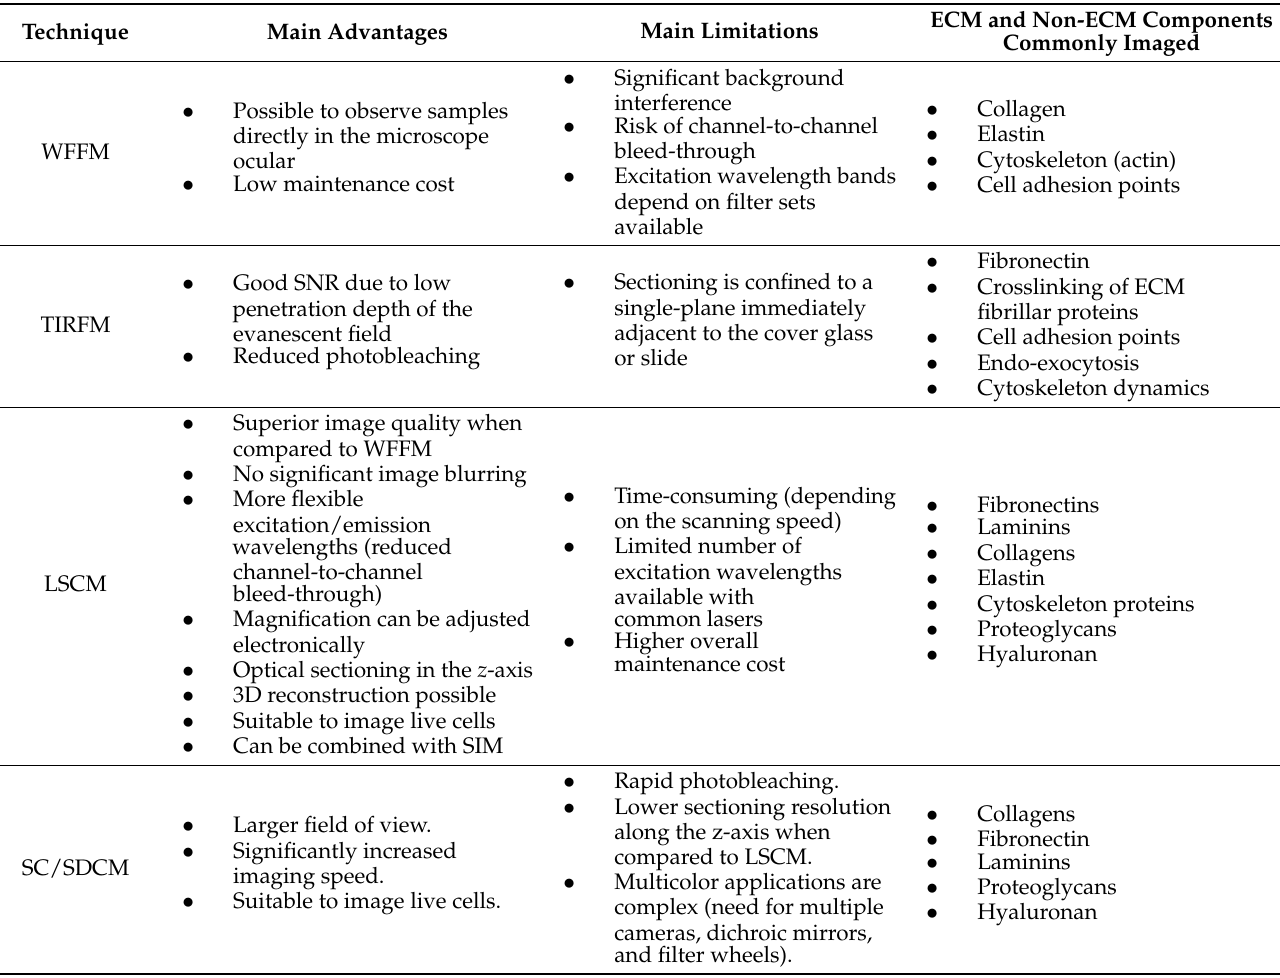
Table 1. The most commonly used linear fluorescence-based and diffraction-limited microscopy modalities to assess ECM